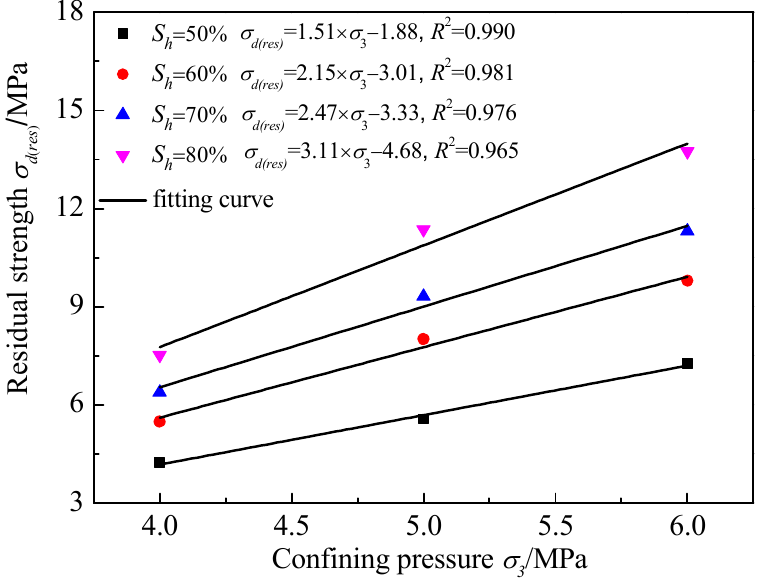
Figure 11. Variation of the residual strength with the confining pressure.